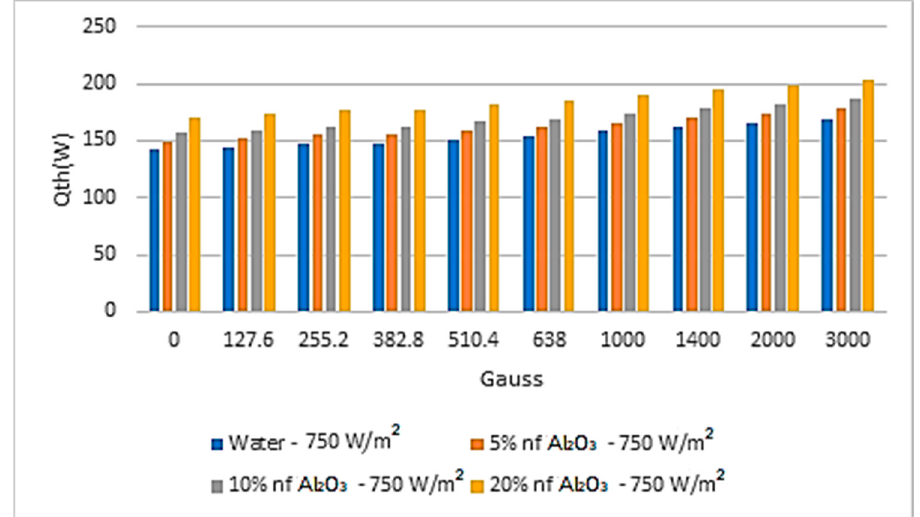
Figure 11. Thermal energy in the hybrid system generated by PV-Th solar panels with different magnetic fields.